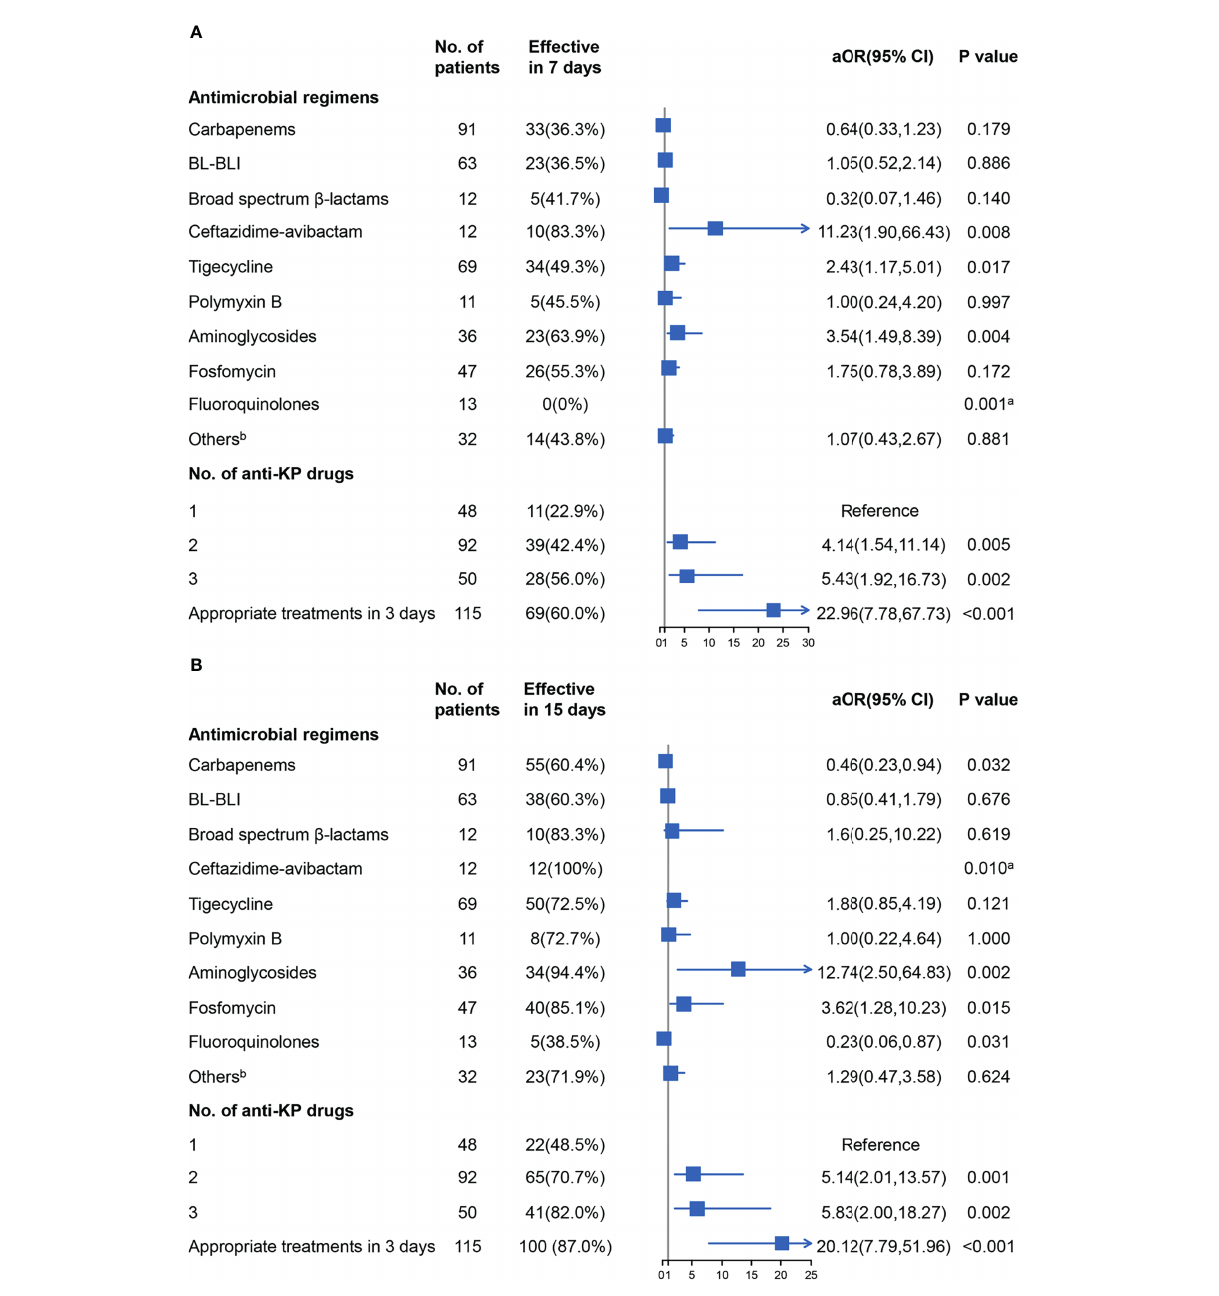
FIGURE 5 | Results of logistic analysis of the associations between the antimicrobial agents and treatment effectiveness in 7 days (A) and 15 days (B) were shown, and adjusted odds ratio (aOR) with 95% con fi dence interval (CI) were adjusted for age, sex, comorbidities, clinical status, and site of infection as potential confounders. a Fisher ’ s exact test was used to evaluate associations for “ zero ” frequency was present. b Other drugs included tetracyclines and sulfamethoxazole- trimethoprim. BL-BLI, b -lactam/ b -lactamase inhibitors (cefoperazone-sulbactam and piperacillin-tazobactam); KP, Klebsiella pneumoniae